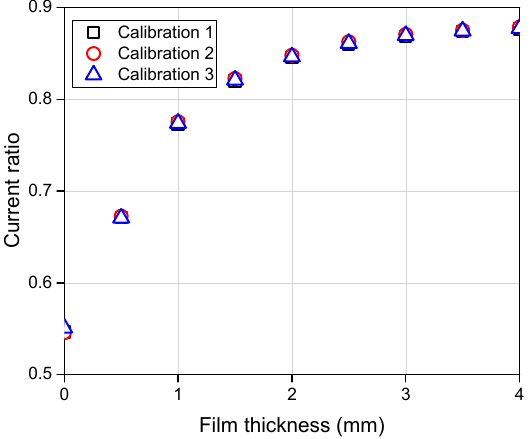
Figure 12. Calibration result (repeatability test).